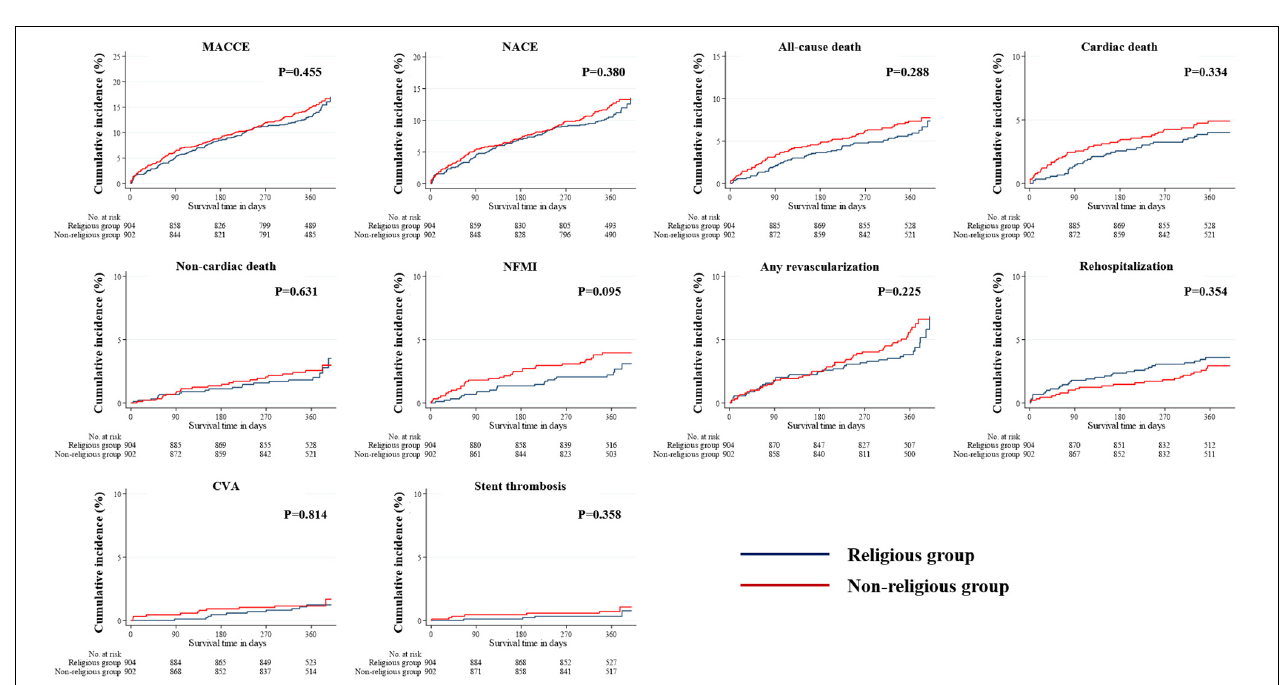
FIGURE 4 | Incidences of primary and secondary clinical outcomes in all patients after a 1-year follow-up (after PSM-adjusted analysis). The figure shows the Kaplan–Meier curves for the cumulative event rates according to the presence or absence of religious faith. PSM, propensity score matching.